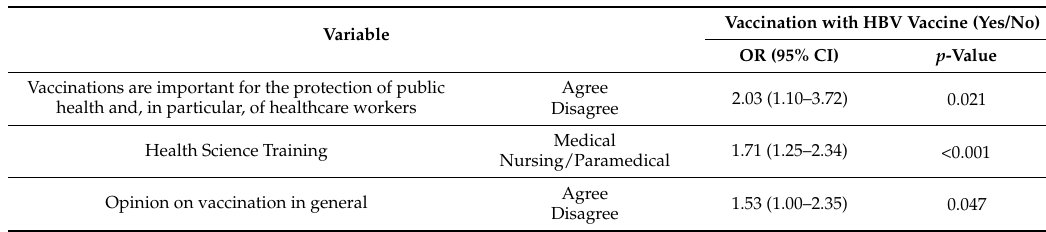
Table 3. Multivariate analysis of HBV